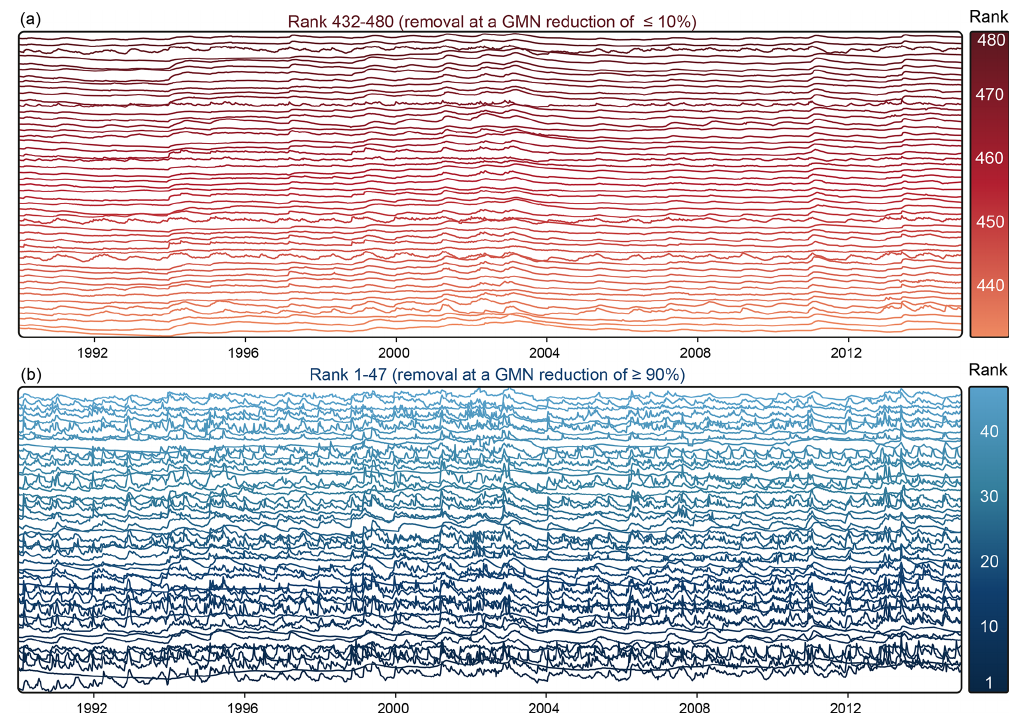
Figure 4. Stacked z -transformed hydrographs of the 10% most important monitoring wells (blue; panel b ) and the 10% most redundant monitoring wells (red; panel a ). Coloring and stacked order reflect the ranking